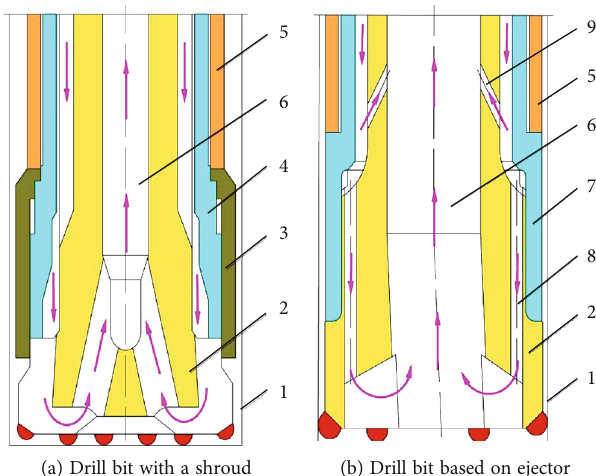
Figure 2: Drill bit with reverse air circulation. 1: borehole wall; 2: drill bit body; 3: shroud; 4: drive sub; 5: hammer casing; 6: central passage; 7: connector; 8: fl ushing nozzles; 9: inner suction